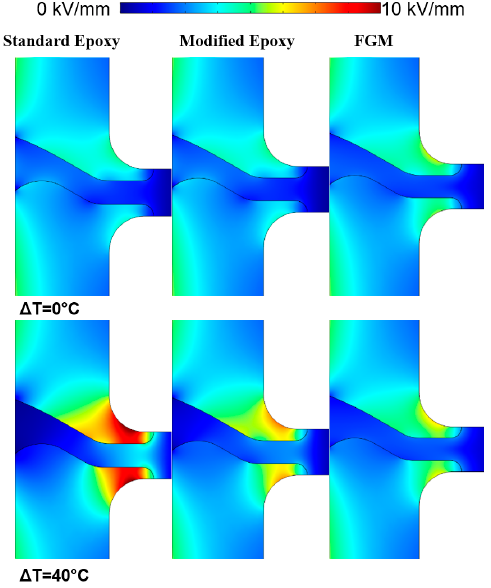
Figure 10. Electric field distributions around the spacer model made of different materials at uniform temperature (T = 30 °C) and Δ T = 40 °C under DC voltage of 131.3 kV.